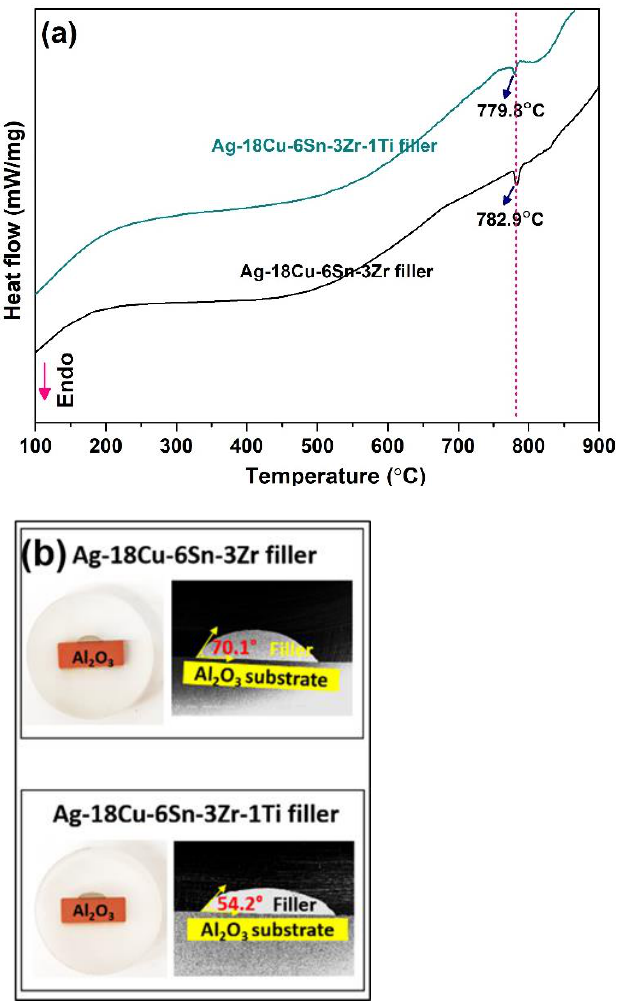
Figure 4. ( a ) DSC curve; ( b ) contact angle of Ag-18Cu-6Sn-3Zr and Ag-18Cu-6Sn-3Zr-1Ti brazing filler on Al 2 O 3 substrate.